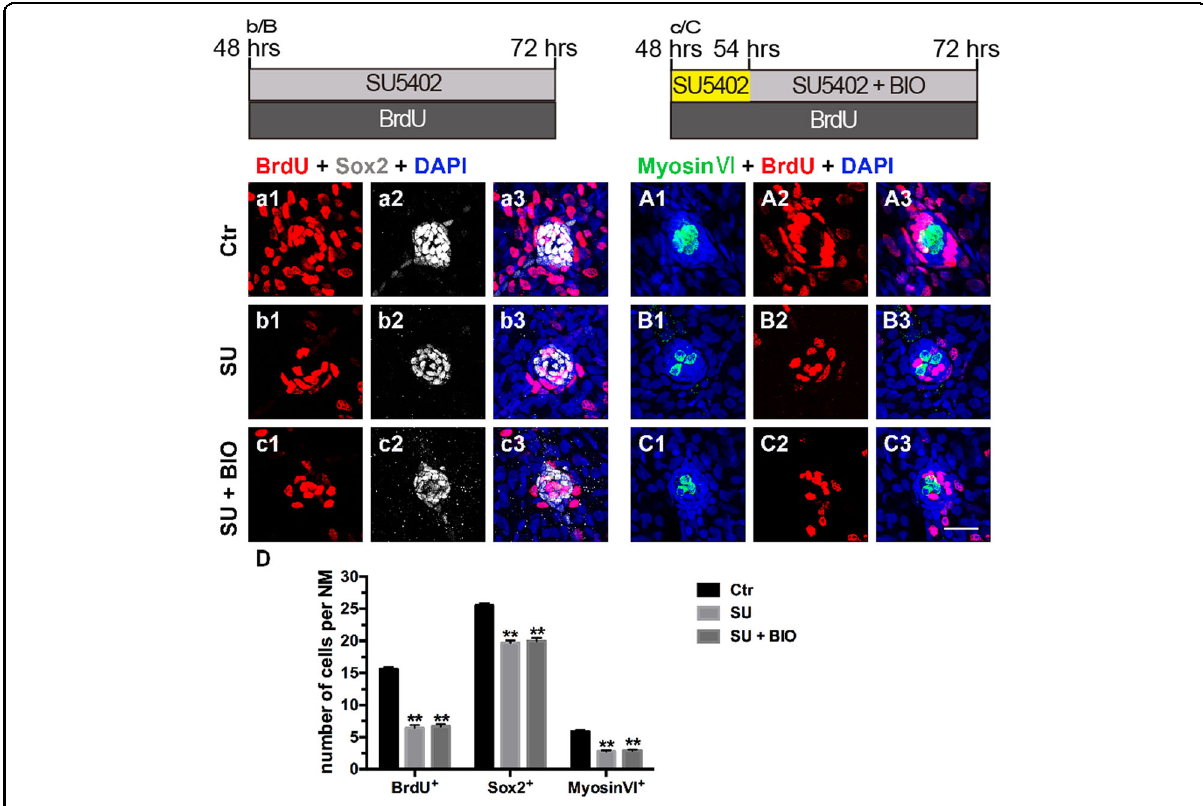
Fig. 3 Effects of Wnt activation on cell proliferation and differentiation in FGF-inhibited larvae. a1 – C3 : Proliferative cells labeled with BrdU (red), SCs labeled with Sox2 (white), and HCs labeled with myosin VI (green). a1 – A3 : Control neuromast; b1 – B3 : After addition of SU5402; c 1 – C3 : After 6 h of incubation with SU5402, BIO and SU5402 were added for 18 h; d : Quanti fi cation of the proliferative cells (BrdU + ), SCs (Sox2 + ), and HCs (Myosin VI + ) shown in a1 – C3 . n = 5 – 7 fi sh per group. ** Indicates p < 0.001, and error bars indicate the standard error of the mean. Scale bar in C3 = 20 μ m for a1 –